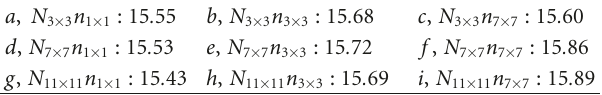
Table 6: SNR for the restorations using the proposed SA prior with the corresponding neighborhood combinations in Table